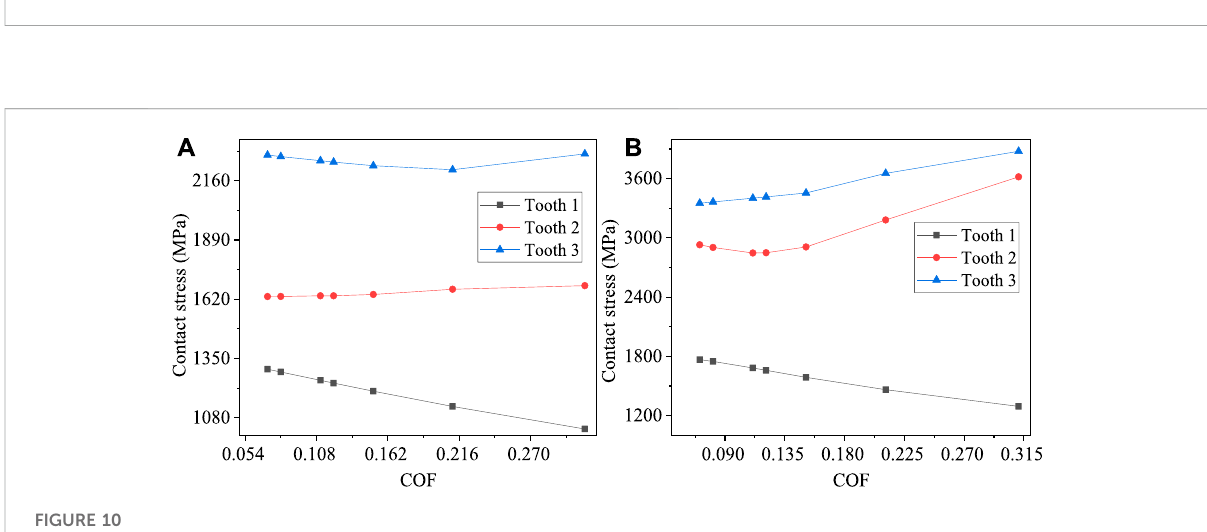
FIGURE 10 Contact stress analysis curve. (A) Average contact stress and (B) Maximum contact